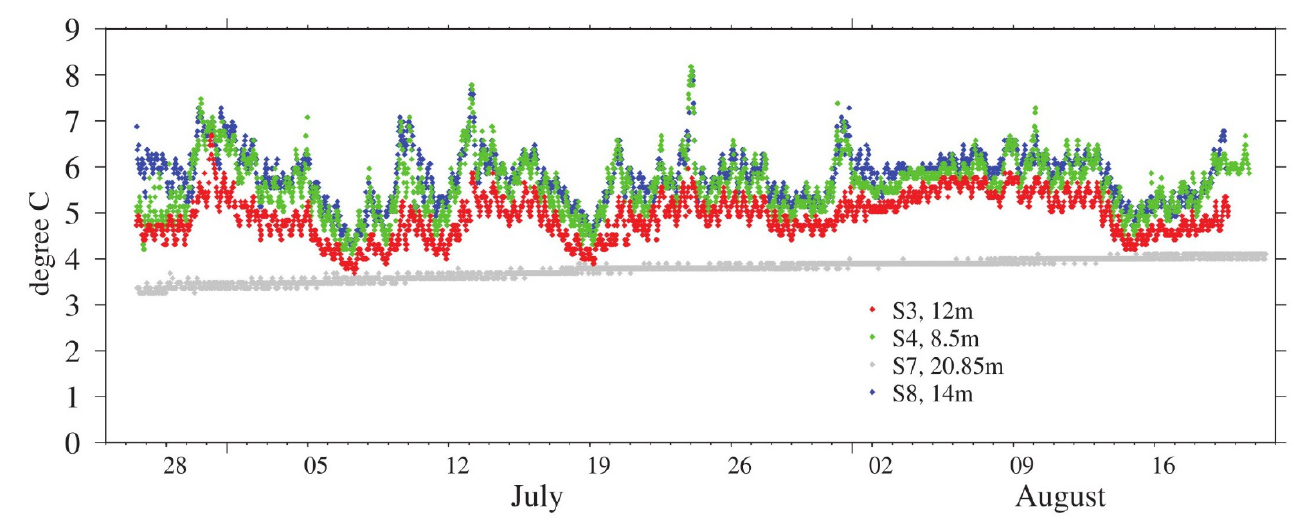
Figure 9. Compiled temperature profiles of the four HOBO dataloggers in summer of